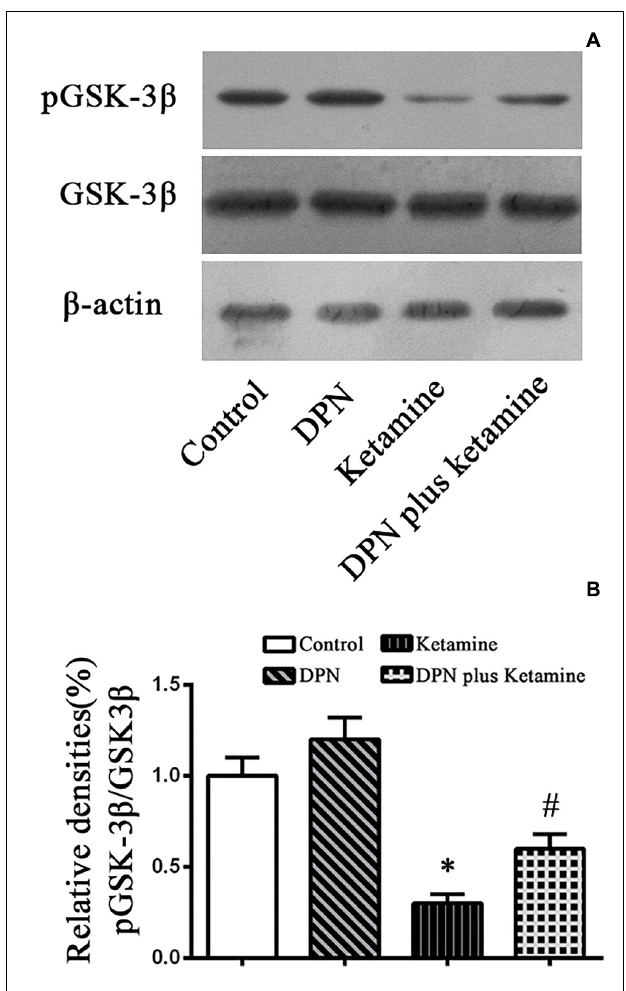
FIGURE 4 | Detection pGSK-3 β protein by western blotting. (A) The typical image of Western blotting to assess pGSK-3 β in NSPCs 24 h after different treatment. (B) Quantification of pGSK-3 β protein level normalized to GSK-3 β after different treatments. ∗ P < 0.01 compared with the control, # P < 0.01 compared with ketamine group. Data were collected from three independent experiments and are presented as means ±